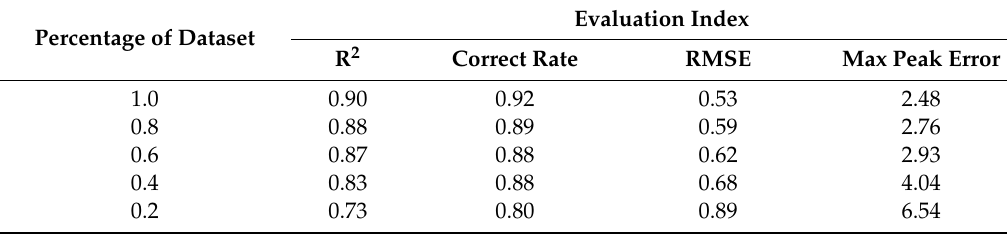
Table 17. Evaluation index value when the number of training datasets was changed. Percentage of